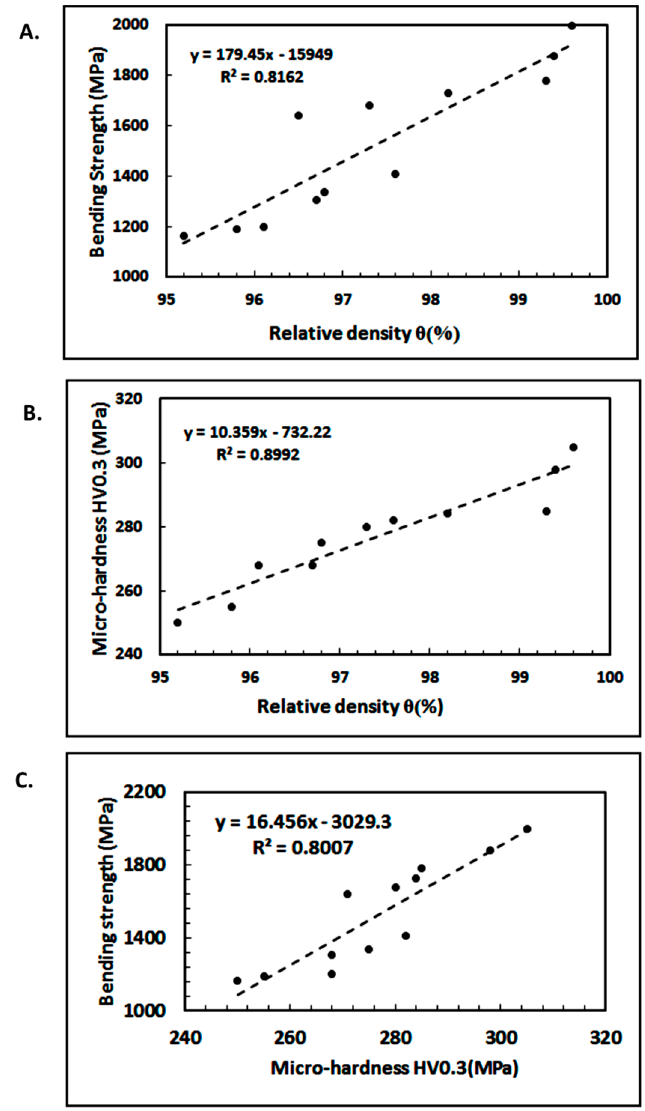
Figure 10. (A-C) Linear dependence of bending strength and microhardness on the relative density of sintered